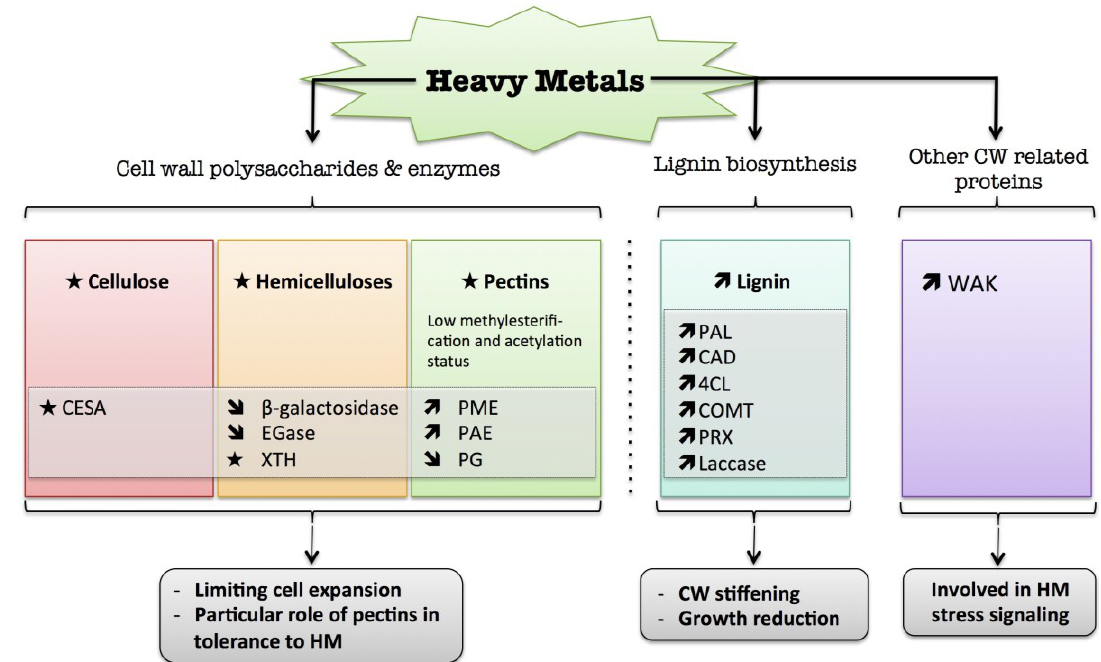
Figure 6. Diagram summarizing the plant cell wall response to heavy metals. The schematic presentation is deduced from the results of different studies reported in the